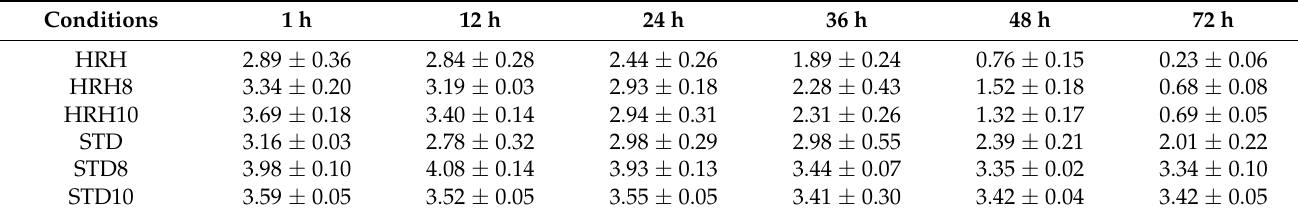
Table 4. Transverse strength with standard deviation [MPa] of studied cores stored under defined conditions (different shoot- ing pressures used within the core production): HRH—High relative humidity, constant temperature—RH = 90% ± 5%, t = 25 ◦ C, Shooting pressure 6 bar; HRH8—High relative humidity, constant temperature—RH = 90% ± 5%, t = 25 ◦ C, Shoot- ing pressure 8 bar; HRH10—High relative humidity, constant temperature—RH = 90% ± 5%, t = 25 ◦ C, Shooting pressure 10 bar; STD—Laboratory ambient conditions—RH = 60% ± 5%, t = 25 ◦ C, Shooting pressure 6 bar; STD8—Laboratory ambient conditions—RH = 60% ± 5%, t = 25 ◦ C, Shooting pressure 8 bar; STD10—Laboratory ambient conditions— RH = 60% ± 5%, t = 25 ◦ C, Shooting pressure 10